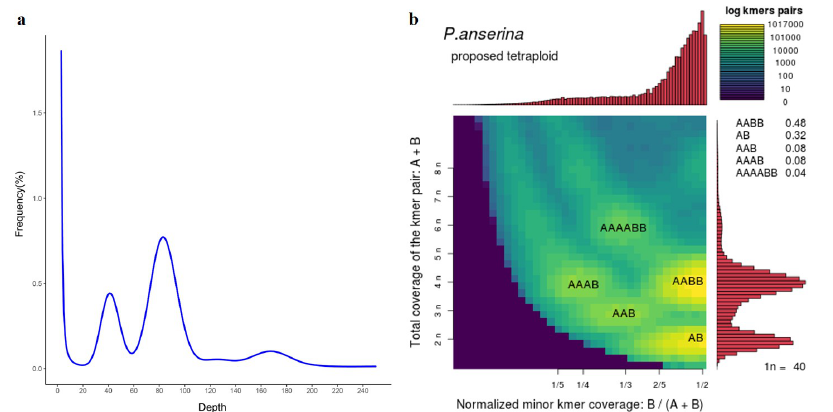
Figure 1. Genome size and ploidy analysis. ( a ) The k-mer (k = 17) frequency distribution. The sharp peak ( ∼ 83) is the homozygous region of genome and the smooth peak ( ∼ 168) reflected allotetraploidy. ( b ) The ploidy analysis for reference-free profiling of polyploid genomes.